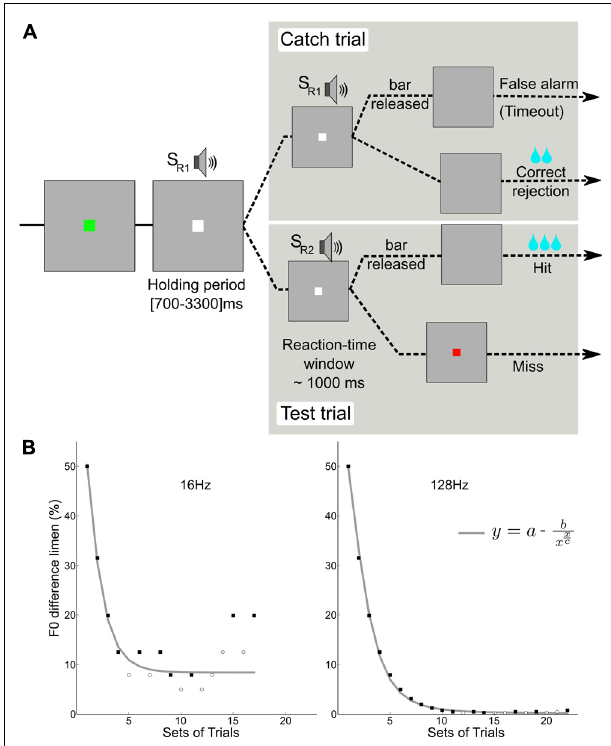
FIGURE 1 | Behavioral paradigm. (A) A go/no-go task was used in which the monkey had to release a touch bar at each detection of a change in F0 during test trials (2/3 of the trials), and keep holding the bar during catch trials (1/3 of the trials). (B) Two adaptive tracks for subject M1; detection of a change in the pitch of two reference F0s (16 and 128 Hz).The staircase data were fitted with an asymptotic function using a standard least-squares algorithm. Filled squares and open circles represent hits and misses,